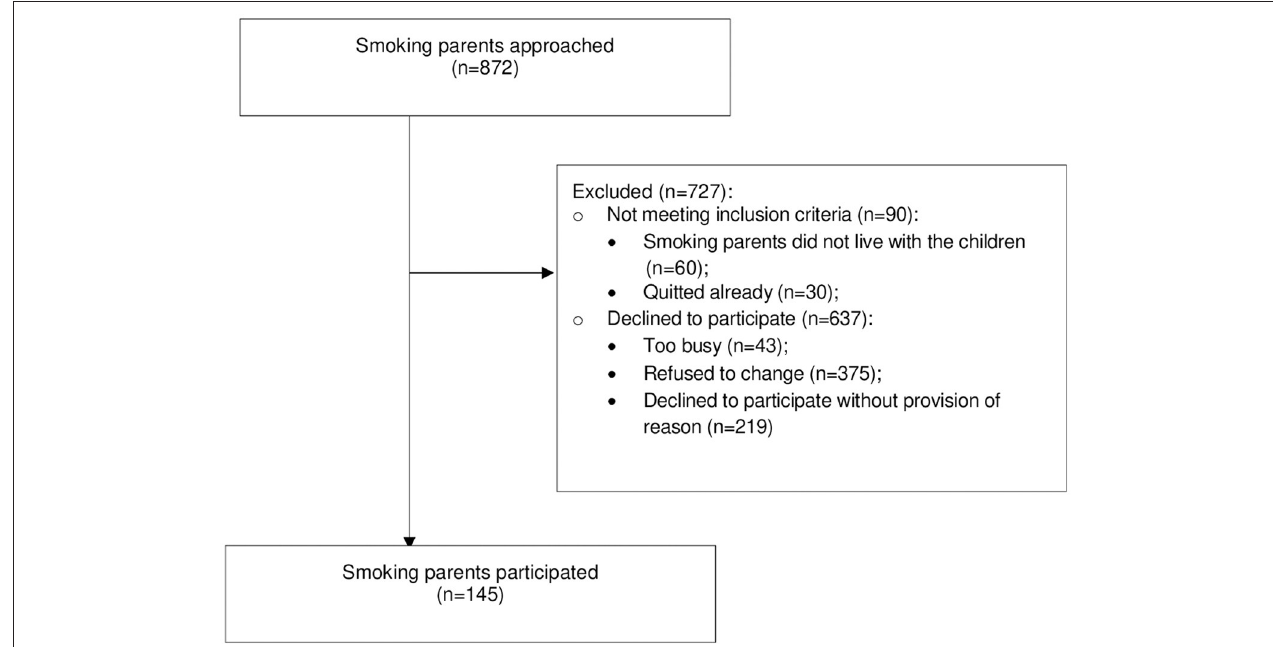
FIGURE 1 | Flow diagram of study